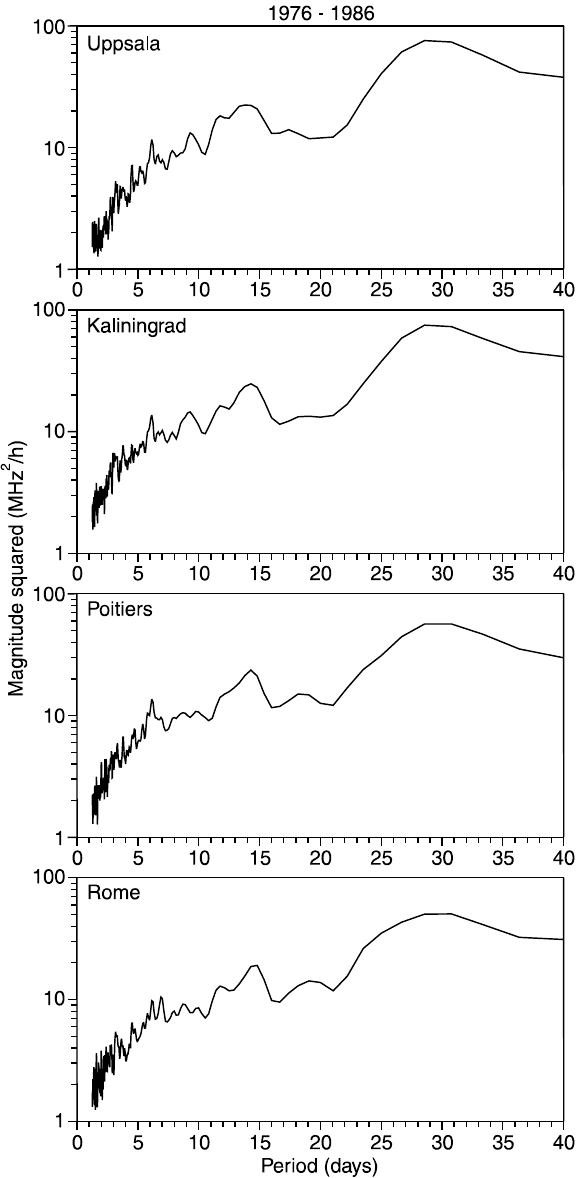
Fig. 1. Averaged periodograms of f 30 h to 40 days for the whole solar cycle 21 calculated as a mean of 126 spectra of successive 4-month intervals shifted by 1 month Table 1. Lower and upper limits of f the periodic range from 2 to 35 days Periodic band